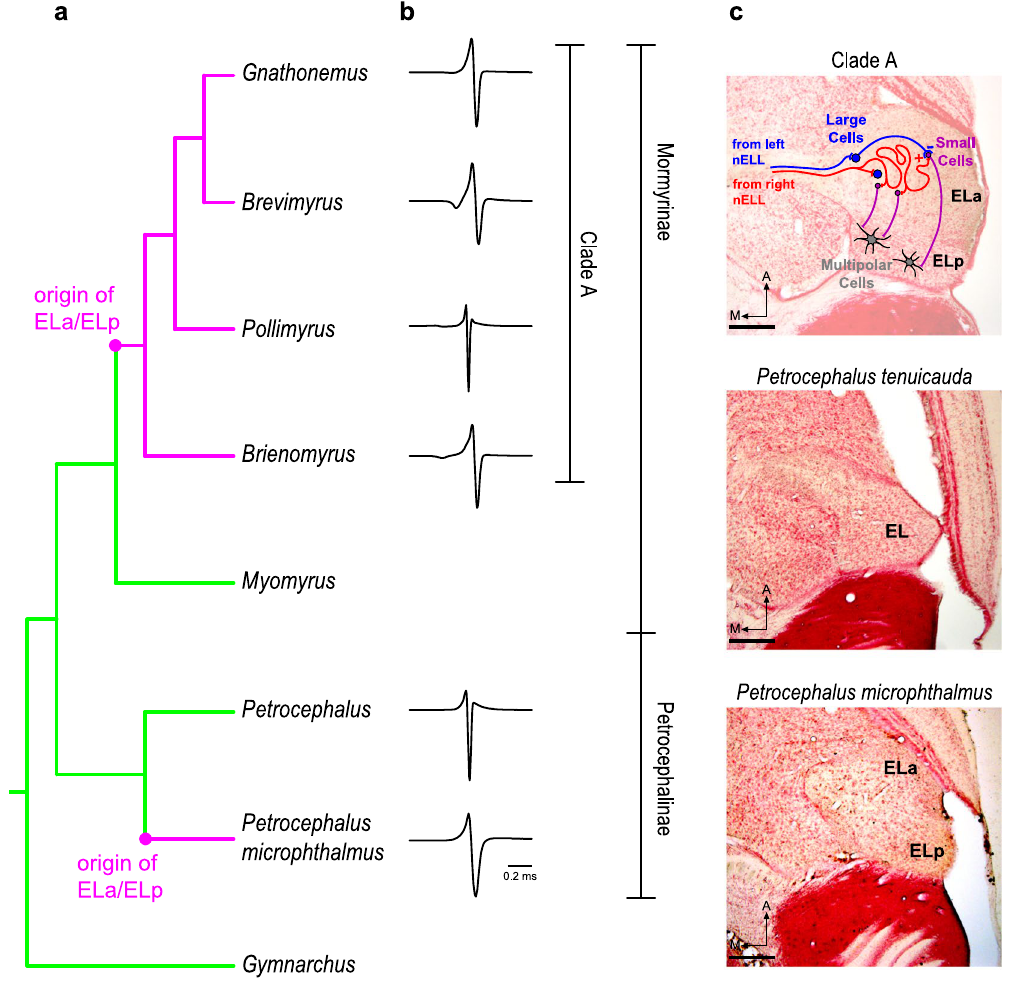
Figure 1. The perceptual ability to detect variations in EOD waveform is associated with parallel evolutionary changes of the central electrosensory system in mormyrids. Based on a parsimonious reconstruction of extant taxa 12 , the most likely ancestral state of the exterolateral nucleus of the midbrain (EL) is small and undifferentiated (green) ( a , c ). In clade A and P . microphthalmus , however, this nucleus is enlarged and subdivided into anterior (ELa) and posterior (ELp) regions (magenta) ( a , c ). Only species with ELa/ELp are sensitive to EOD waveform variation (i.e., the shape of the electric pulses used in communication) ( b ). In clade A, the first stages of EOD waveform analysis are performed in ELa ( c ). Cells from the hindbrain nucleus of the electrosensory lateral line lobe (nELL) project bilaterally to ELa (red and blue). Upon entering ELa, the nELL axons synapse onto large inhibitory cells (blue) and then follow a long and tortuous path, synapsing onto numerous small cells (purple) throughout their length. Large inhibitory cells project onto small cells, establishing a delay-line anti-coincidence detection mechanism by which small cells analyze EOD waveform. Small cells then project to multipolar cells (gray) in ELp that are sensitive to inter-pulse intervals (IPIs). Cladogram in ( a ) is based on consensus trees 43, 44 and includes genera of the species used in this study, as well as the genera Myomyrus and Gymnarchus , which were important for previous reconstructions of the EL-ELa/ELp trait 12 . EOD waveforms in ( b ) are from species used in the present study (from top to bottom): Gnathonemus petersii , Brevimyrus niger , Pollimyrus adspersus , Brienomyrus brachyistius , Petrocephalus tenuicauda , and Petrocephalus microphthalmus . Photomicrographs in ( c ) are from 50- µ m horizontal sections of the brain at the level of the midbrain and scale bars represent 200 µ m. A: anterior. M: